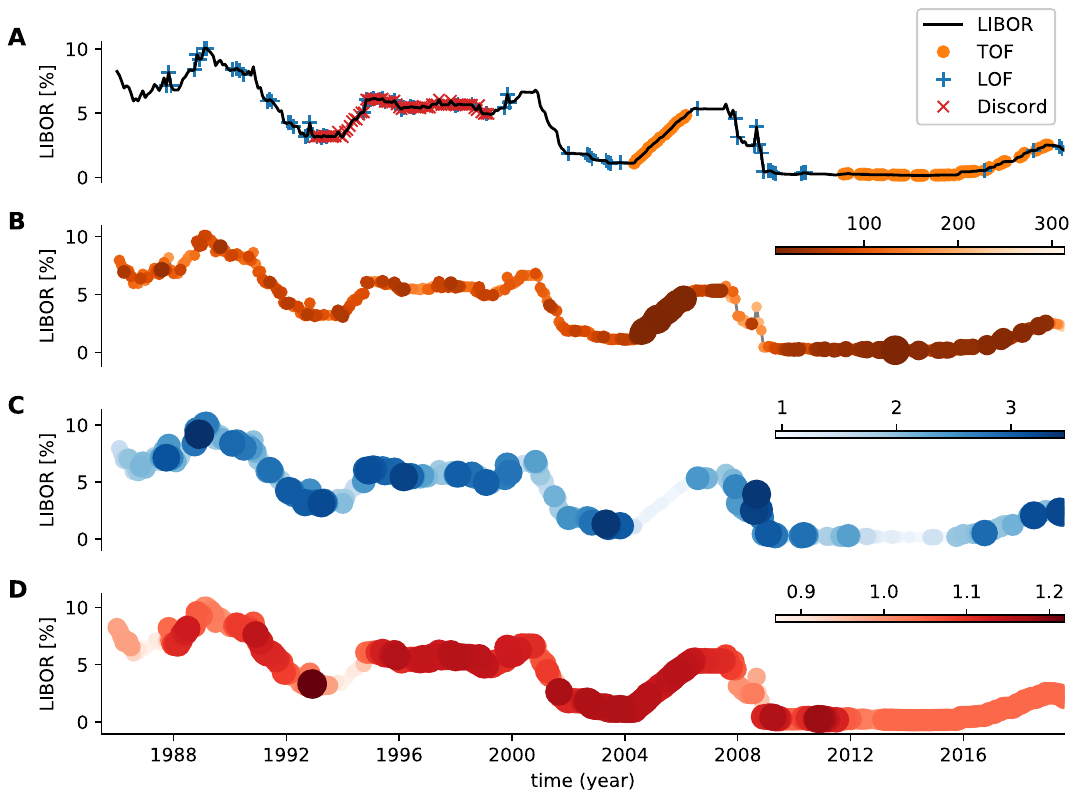
Figure 7. Analysis of LIBOR dataset. The detections were run on the temporal derivative of the LIBOR time series. ( A ) time-series with detections. ( B ) TOF score values. ( C ) LOF score values. ( D ) Matrix profile scores by the discord detection algorithm. TOF detected two rising periods: the first between 2005 and 2007 and a second, started in 2012 and lasts until now. While both periods exhibit unique dynamics, they differ from each other as